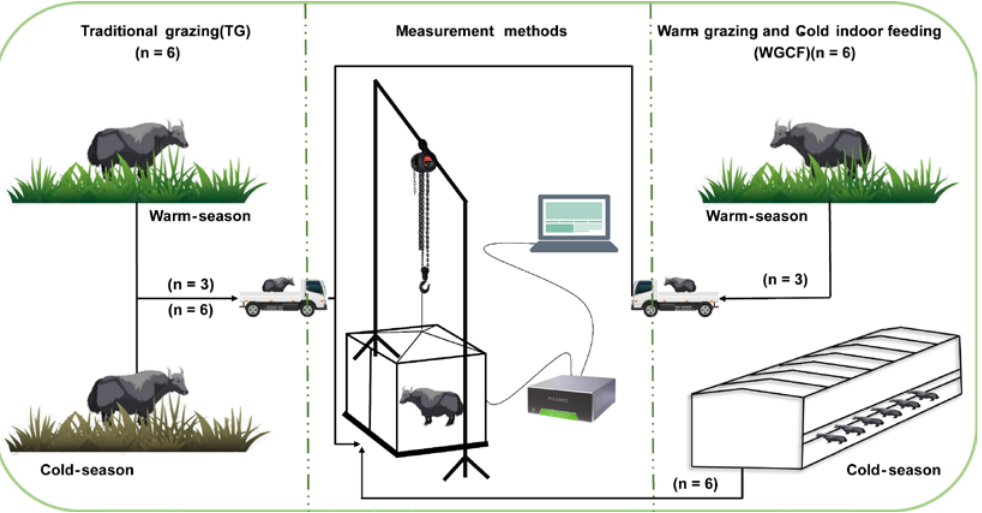
Figure 1. Schematic illustration of the GHG measurement process in two different feeding